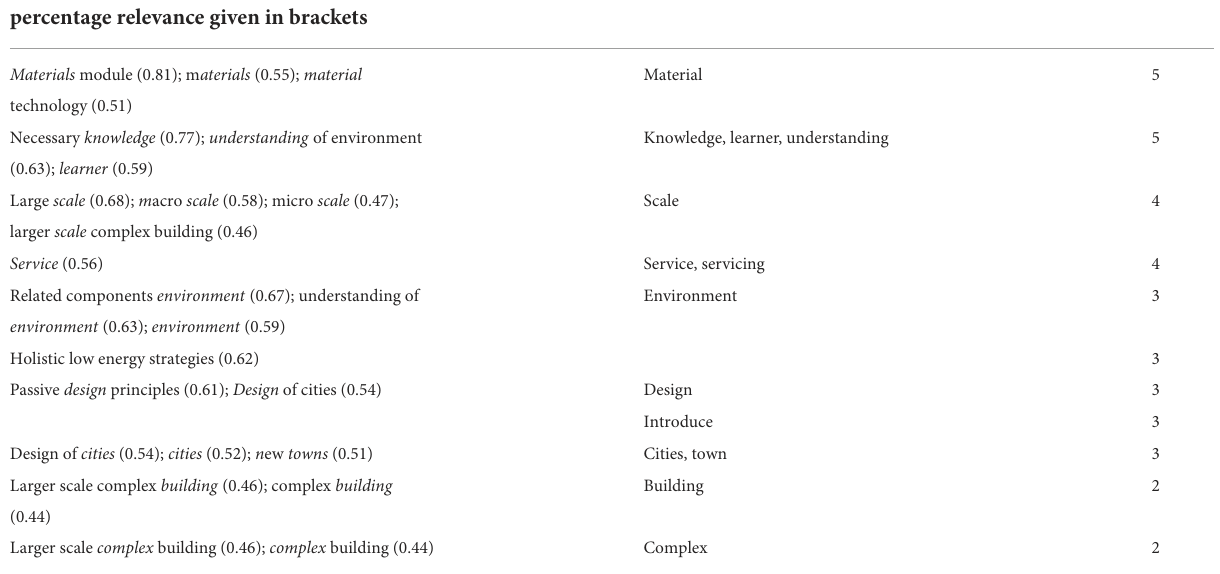
TABLE 1 Comparing returned keywords and percentage relevance from IBM Watson NLU demonstration tool (IBM Watson) to individual keywords and synonyms found in the Environmental Services and Materials module/course overview, ordered by the number of occurrences. Grouped keywords returned by Watson